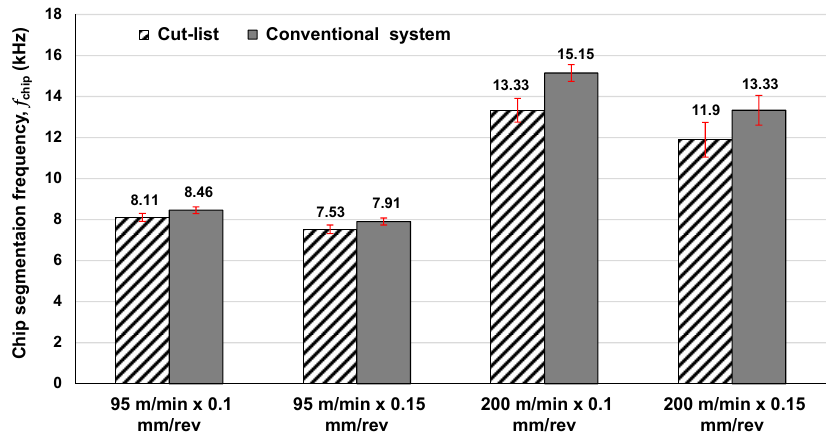
Figure 21. Frequency of segmentation at various cutting conditions for the two supply systems.